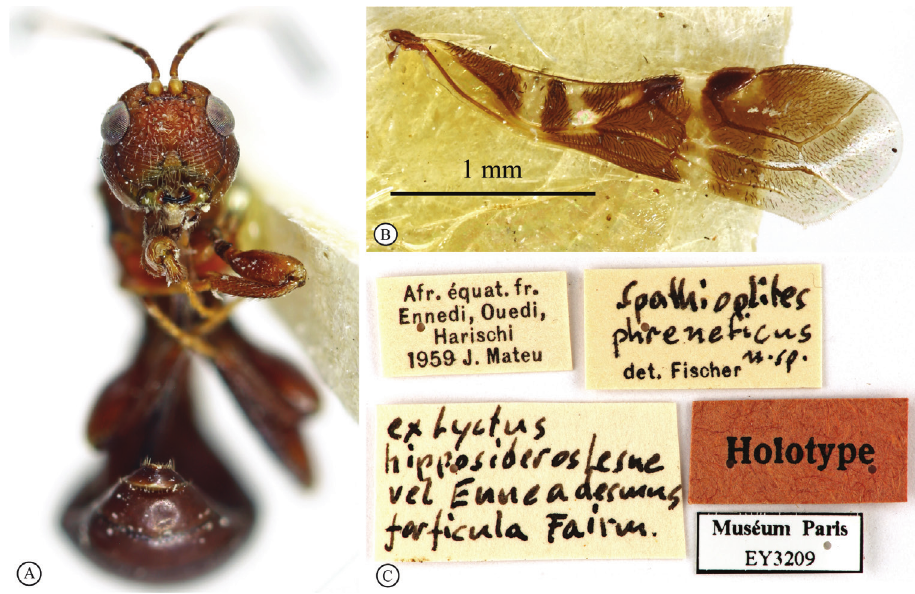
Figure 4. Spathioplites phreneticus , male holotype (MNHN) A head, anterior view B forewing, dorsal view C data